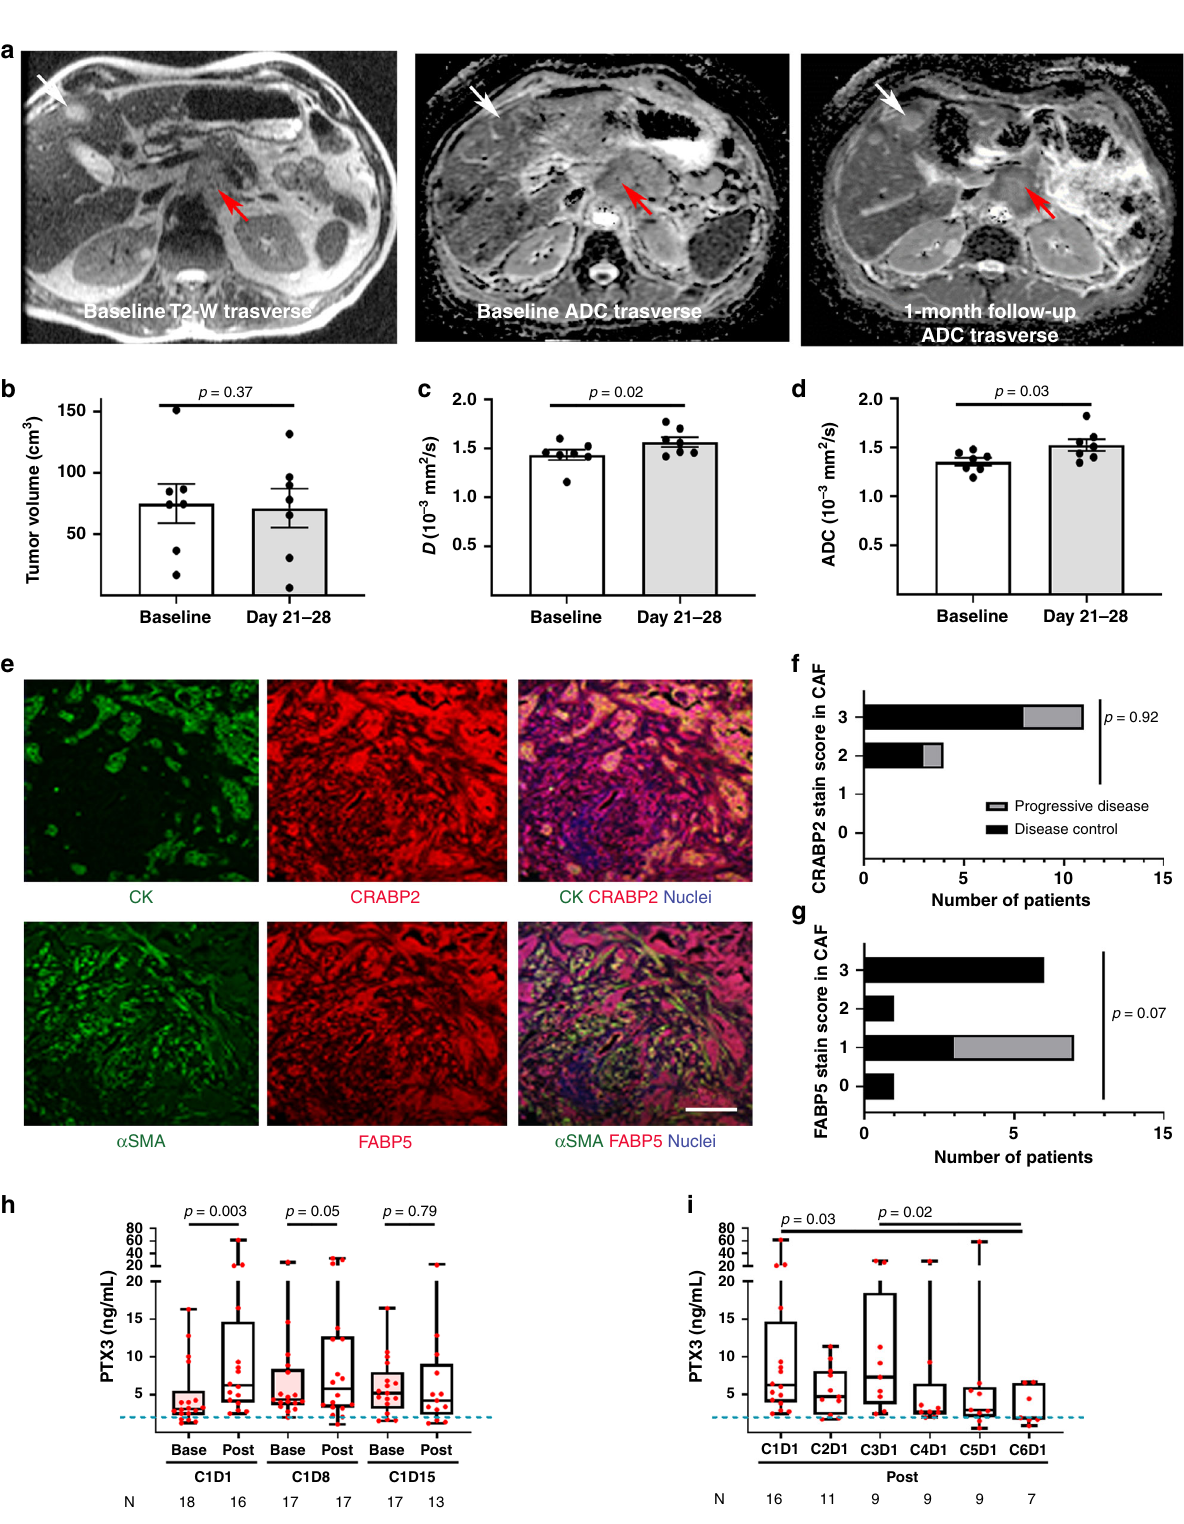
Methods Trial design and patient population . STARPAC was an open-label, multicenter, phase Ib study of ATRA administered with gemcitabine and nab-paclitaxel in patients with locally advanced or metastatic pancreatic cancer, who had not received prior systemic therapy for their disease. Additional eligibility criteria included World Health Organization (WHO) performance status 0 or 1, life expectancy ≥ 12 weeks, and adequate hematologic and end-organ function within 14 days prior to the fi rst study treatment. Major exclusion criteria were known